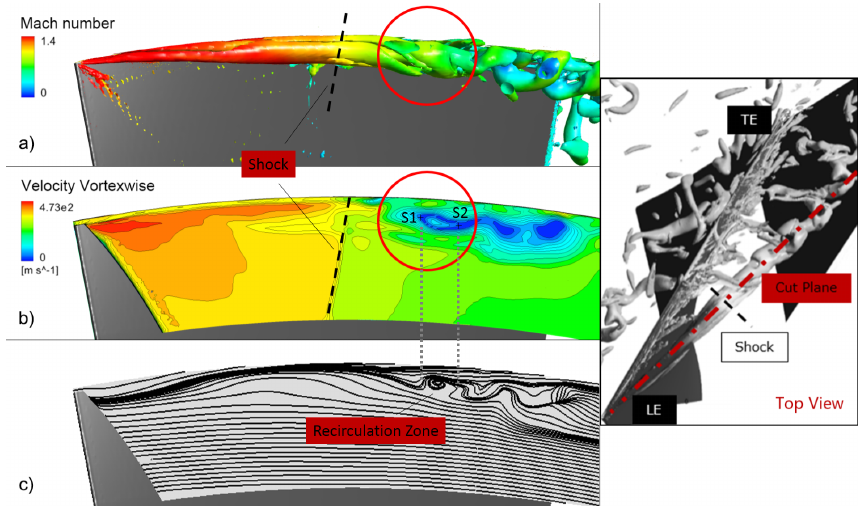
Figure 20. Structures Related to the Breakdown of TLV at